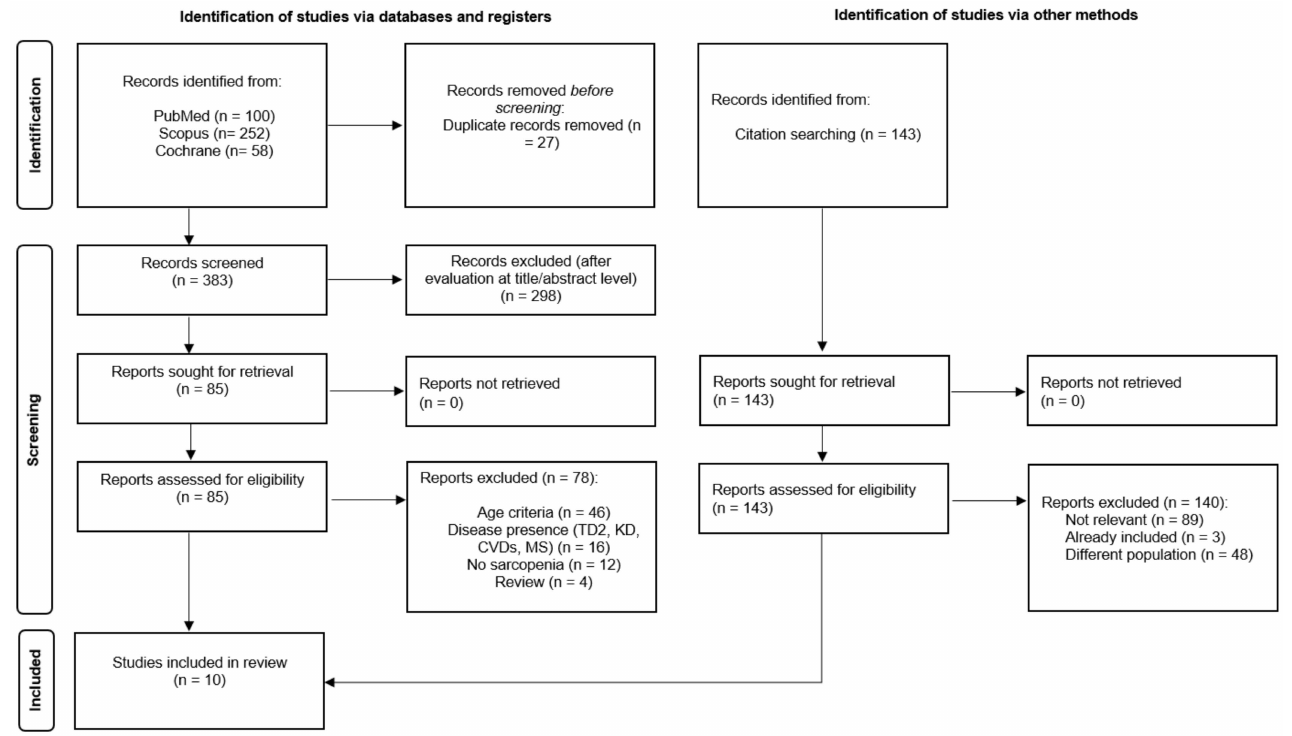
Figure 1. PRISMA [50] flowchart of studies’ selection